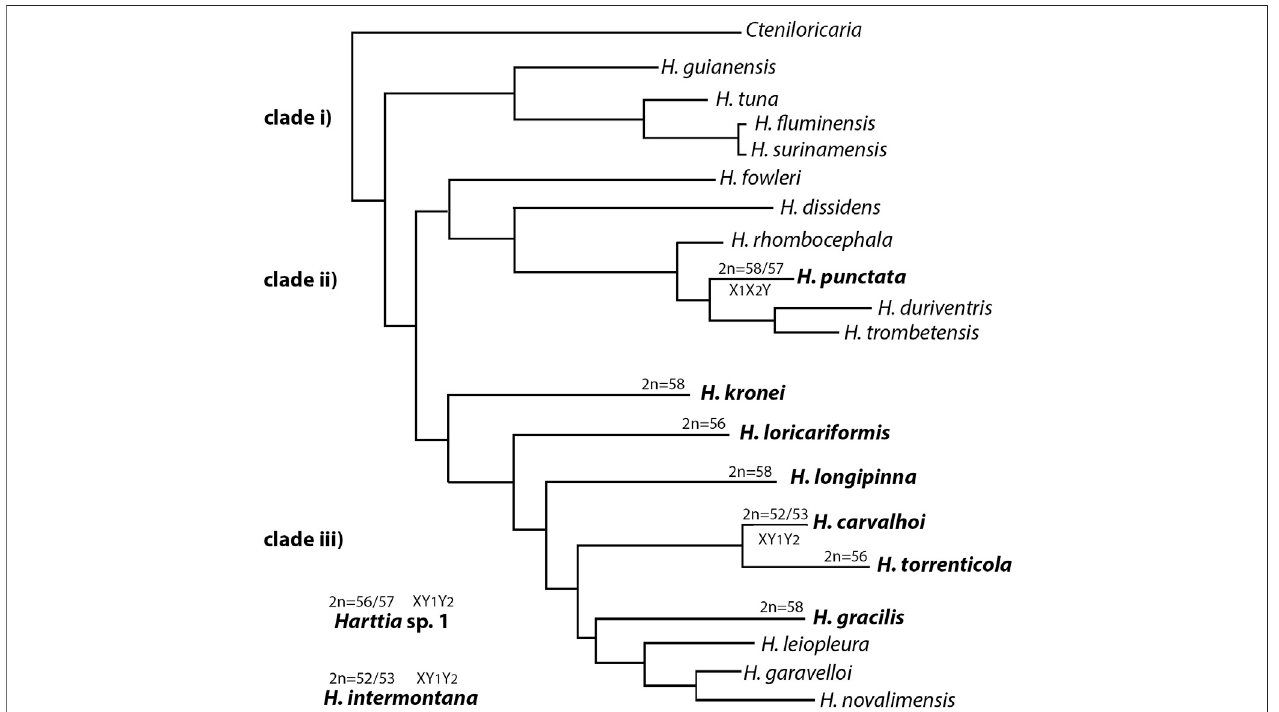
FIGURE 5 | Schematic representation of the phylogenetic relationships among Harttia species adapted from the Londoño-Burbano and Reis (2021). Harttia sp.1 and H. intermontana are not being represented since they were not included in such previous analysis.